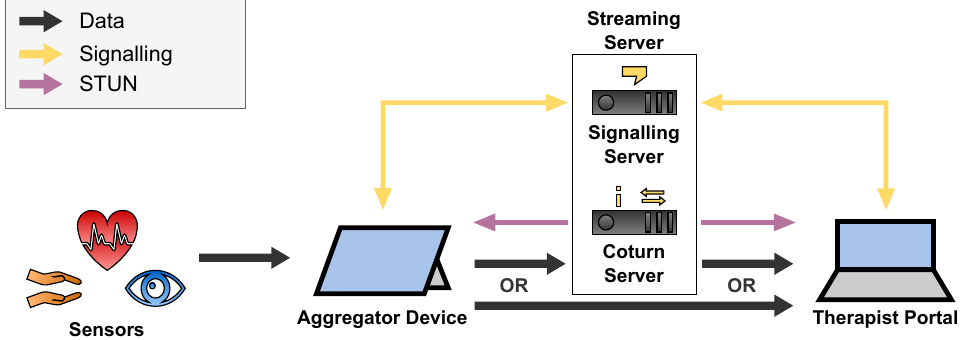
Figure 14. Detailed streaming pipeline including components of Streaming Server, consisting of the Signalling and STUN/TURN